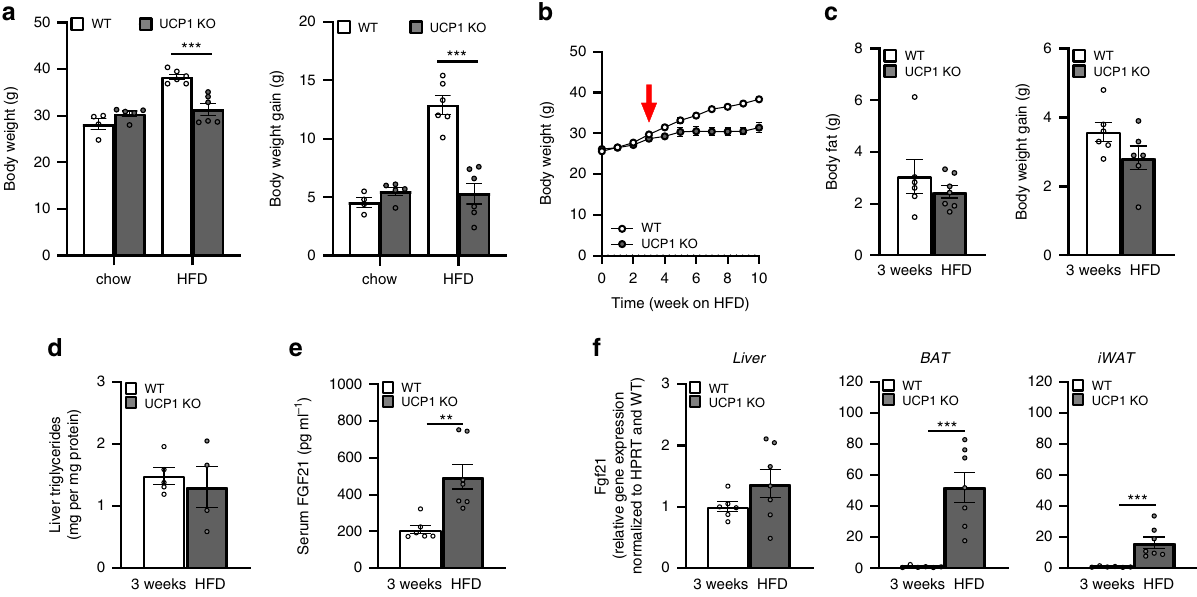
Fig. 1 UCP1 KO mice display resistance to DIO and increased FGF21 at room temperature. At the age of 10 – 12 wks, WT and UCP1 KO mice were transferred from 30 °C to room temperature and high fat diet (HFD) or chow diet was offered for 12 wks. a Mean body weight and body weight gain after 12 wks chow or HFD treatment. b Body weight trajectory at 23 °C on HFD. After 3 wks of HFD feeding at 23 °C, c body fat content and body weight gain, d liver triglycerides, e serum FGF21 levels, and f FGF21 gene expression in liver, BAT and inguinal WAT was assessed. a : n = 4/5/6/6 WT chow/UCP1 chow/WT HFD/UCP1 KO HFD; b : n = 6/6WT/ UCP1 KO; c : n = 6/7 – n = 6/6; d : n = 4/5; e , f : n = 6/7). Data are presented as mean ± SEM. Data were analyzed by Student ’ s t -test ** P < 0.01, *** P < 0.001. Source data are provided as a Source Data fi